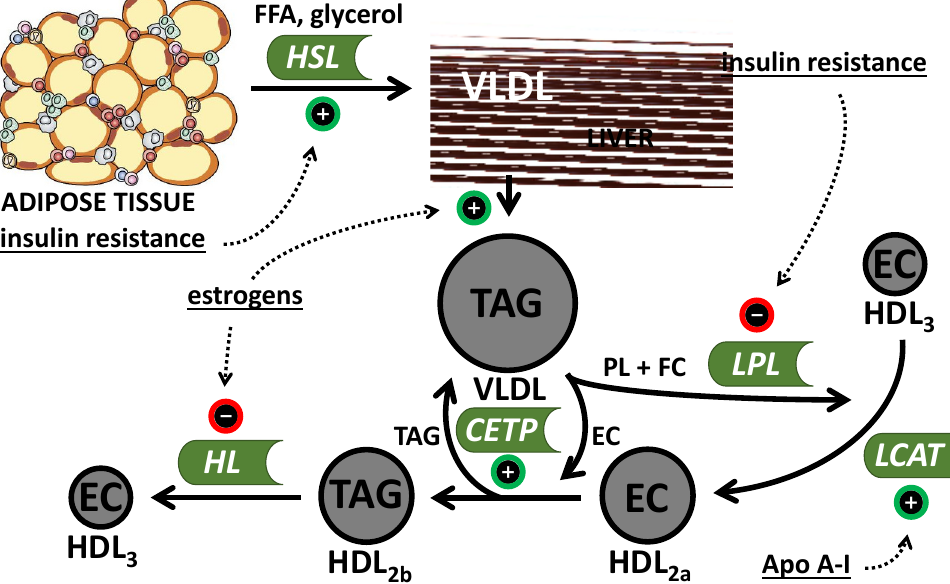
Fig. 1. Schematic representation of major interactions of lipoprotein metabolism during gestation. Activated steps (+) and inhibited steps (-); IR = insulin resistance, PL = phospholipids, FC = free cholesterol, EC = es- terified cholesterol, TG = triglycerides, LPL = lipoprotein lipase, HL = hepatic lipase, CETP = cholesteryl ester transfer protein, LCAT = lecitin cholesterol acyltransferase, HSL = hormone-sensitive lipase. See text for additional explanations. Adapted from Alvarez et al. (ref. 23